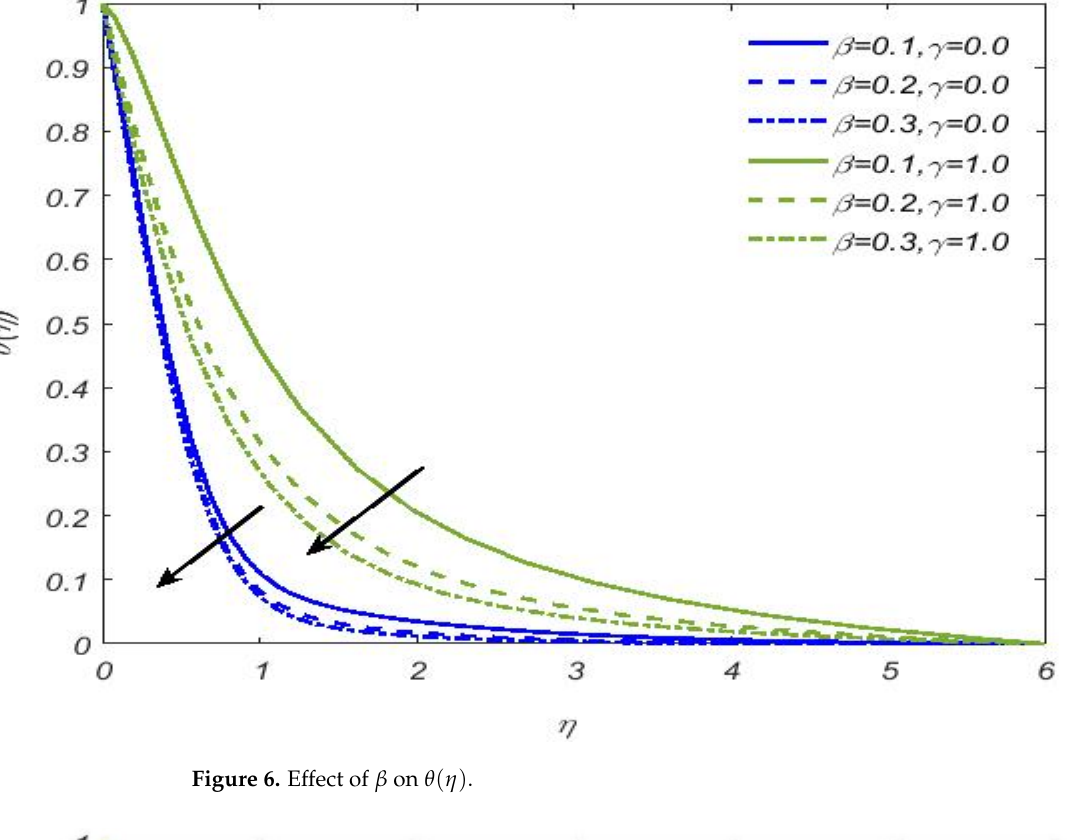
Figure 5. Effect of